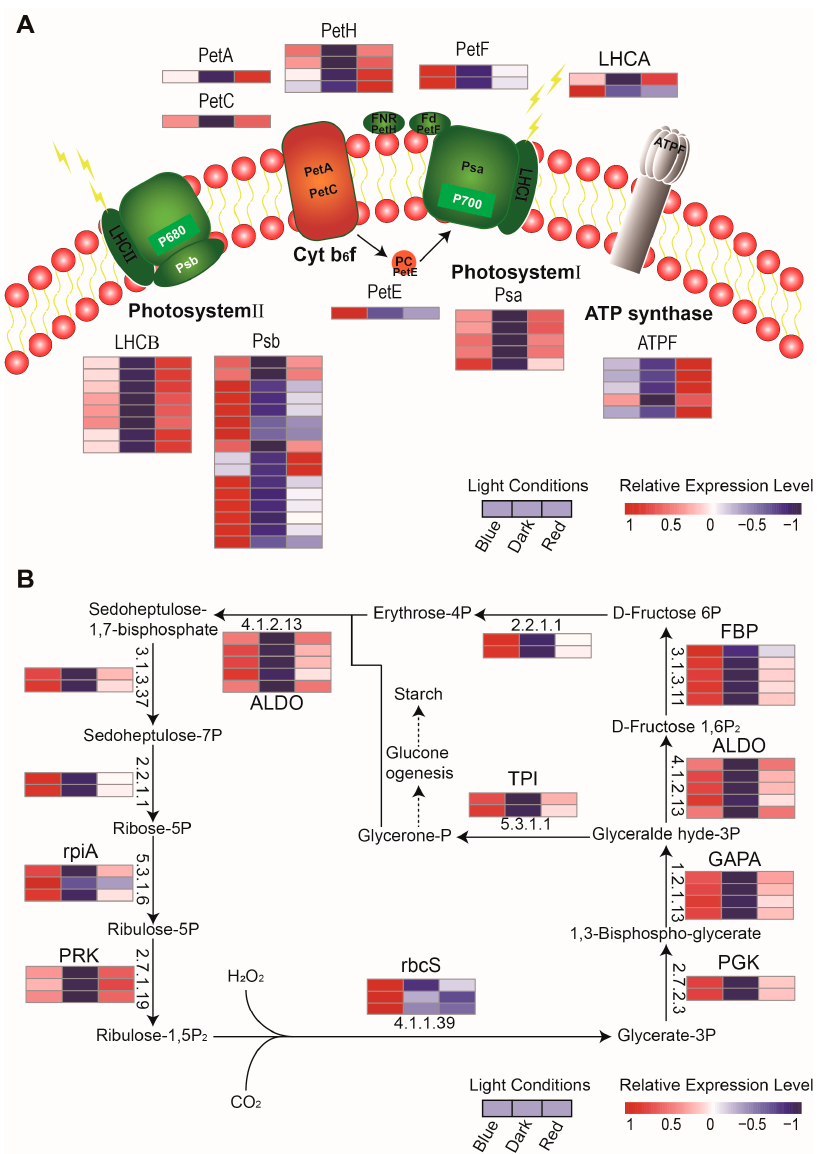
Figure 5. Differences in the regulation of photosynthesis-related proteins in moso bamboo seedlings under blue and red light. ( A ) Expression differences in the photosynthesis KEGG pathway-related DEPs in moso bamboo seedlings under different light treatments. ( B ) Expression differences in the carbon fixation in photosynthetic organism pathway-related DEPs under different light treatments. The arrows indicate the direction of substrate transformation. Heat maps were used to indicate the expression levels of the DEGs encoding the enzymes. (EC:4.1.1.39), ribulose-bisphosphate carboxy- lase large chain; (EC:2.7.2.3), phosphoglycerate kinase; (EC:1.2.1.13), glyceraldehyde-3-phosphate dehydrogenase (NADP+); (EC:4.1.2.13), fructose-bisphosphate aldolase, class I; (EC:3.1.3.11), fructose- 1,6-bisphosphatase I; (EC:2.2.1.1), transketolase; (EC:3.1.3.37), sedoheptulose-1,7-bisphosphatase; (EC:5.3.1.6), ribose 5-phosphate isomerase A; (EC:2.7.1.19), phosphoribulokinase; (EC:5.3.1.1), triosephosphate isomerase